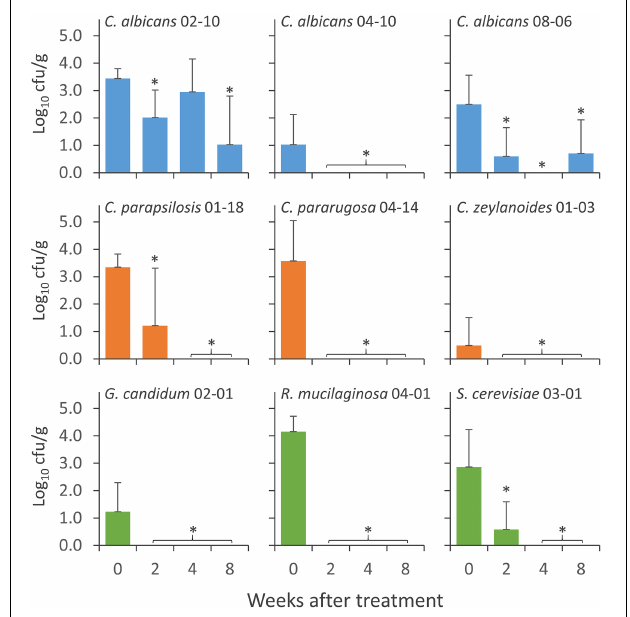
FIGURE 4 | Concentration of the strains of Candida albicans (cyan), NAC (orange), and NCF (green) in the feces of mice groups during the wash period that followed the treatment with C. albicans 02-10, C. albicans 08-06, C. albicans 04-10, C. parapsilosis 01-18, C. pararugosa 04-14, C. zeylanoides 01-03, G. candidum 02-01 (G), S. cerevisiae 03-01 (H), and R. mucilaginosa 04-01 (I). Values are means ( n = 10), the error bars representing the SD. For each strain, ∗ indicate statistically significant difference compared to 0 weeks values (Wilcoxon signed-rank test, P < 0.05).